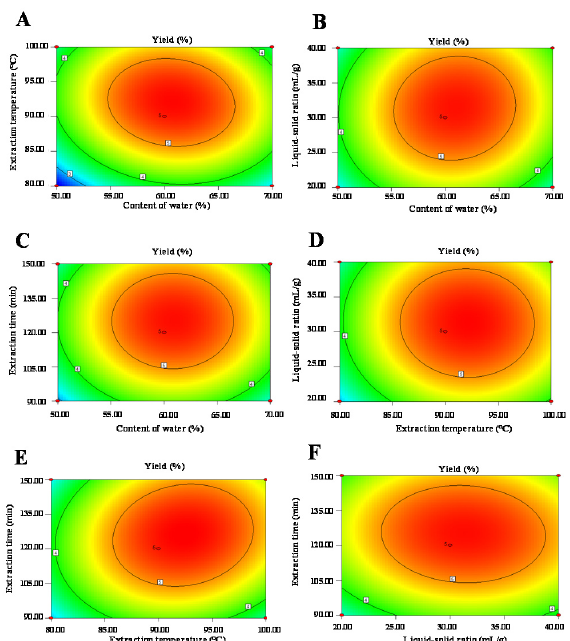
Figure 3. Two-dimensional contour plots of deep eutectic solvent assisted extraction. ( A ) interaction between content of water and extraction temperature; ( B ) interaction between content of water and liquid-solid ratio; ( C ) interaction between content of water and extraction time; ( D ) interaction between liquid-solid ratio and extraction temperature; ( E ) interaction between extraction time and extraction temperature; ( F ) interaction between extraction time and liquid-solid